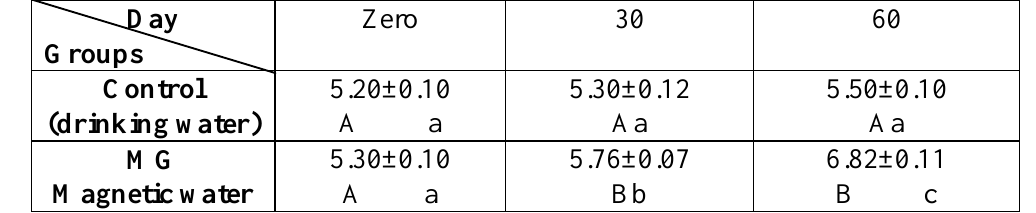
Table (8): Effect of exposure to magnetized water for 60 days on total serum protein (TSP) concentration(g\l)of adult male